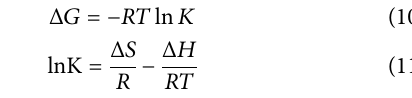
Frontiers in Environmental Science |